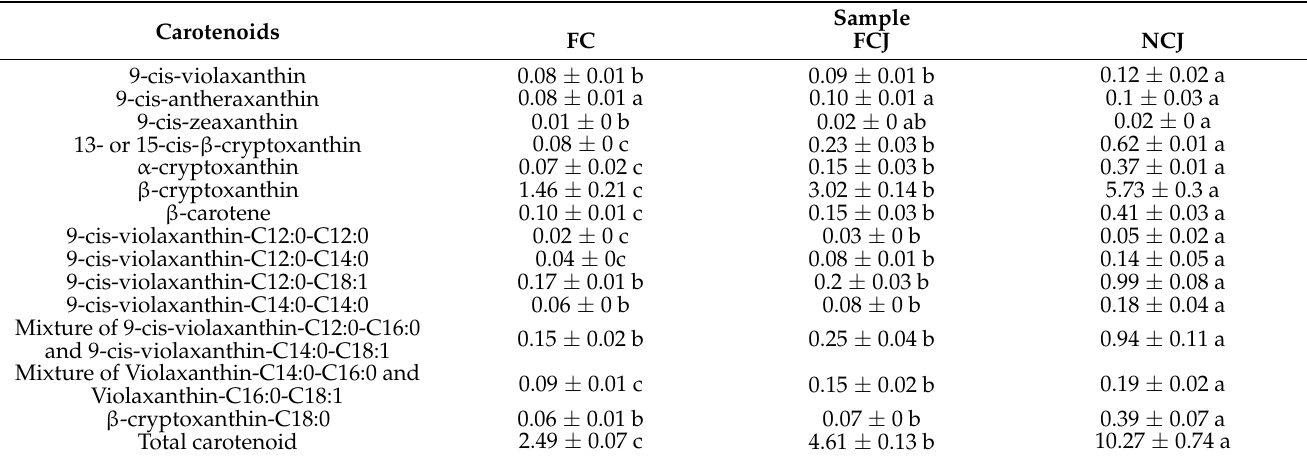
Table 3. Carotenoid contents in micelles of fresh citrus (FC), fresh citrus juice (FCJ), and not-from- concentrate citrus juice (NCJ) ( µ g/g).